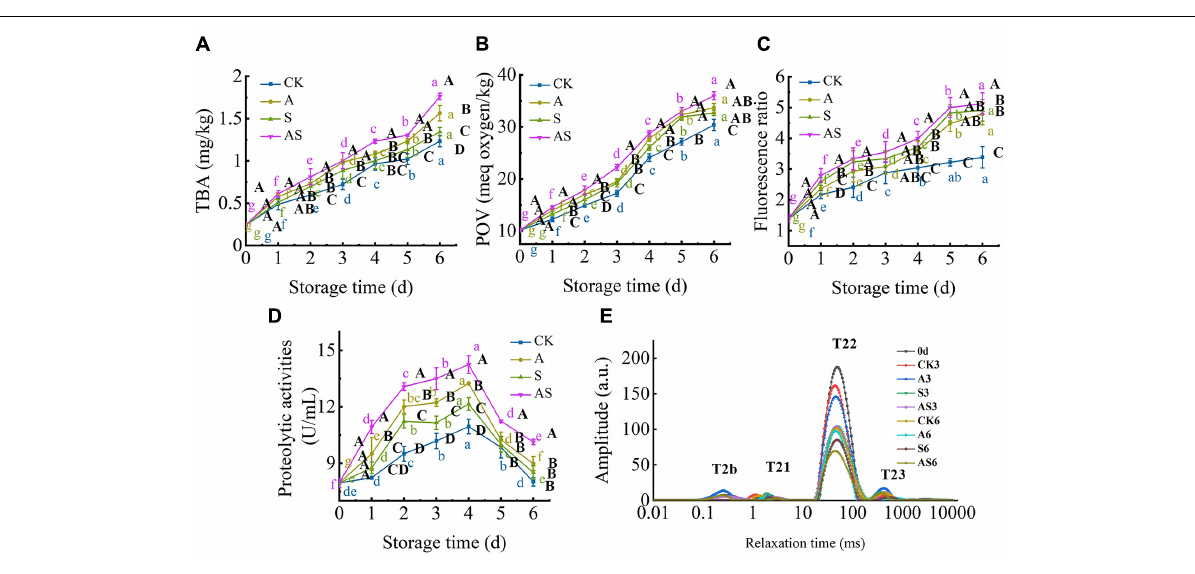
FIGURE 3 | Changes in thiobarbituric acid (TBA) (A) , peroxide value (POV) (B) , fluorescence ratio (FR) (C) , proteolytic activities (D) and T 2 transverse relaxation time (E) in bigeye tuna with different bacterial groups stored at 4 ◦ C for 6 days (each point is the mean value of three determinations). Different capital letters denote significant differences ( P < 0.05) among bacterial groups at the same storage time. Different lowercase letters denote significant differences ( P < 0.05) among the different storage times per treatment